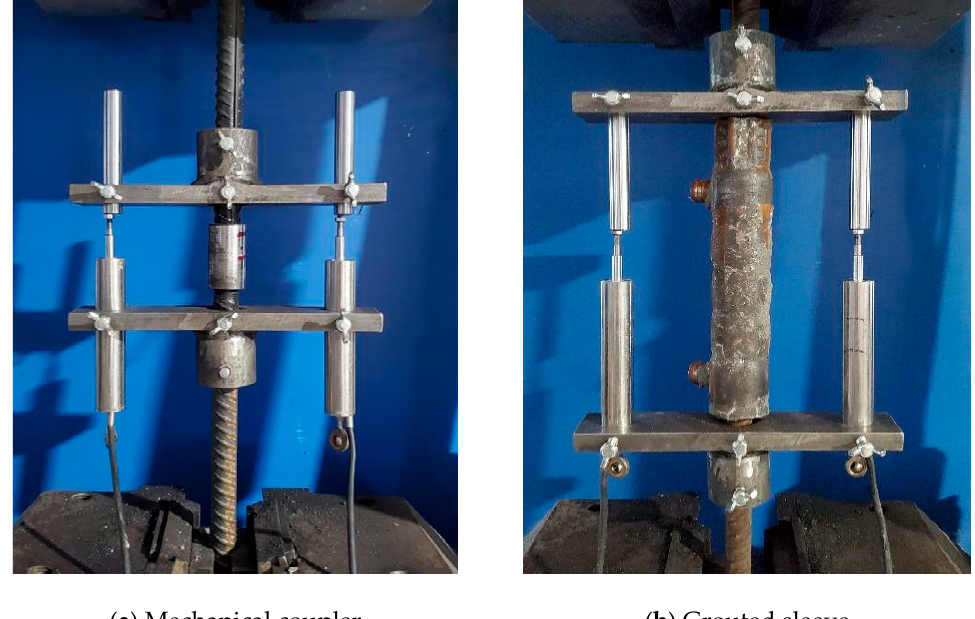
Figure 14. Tensile test setup for different bar connectors.